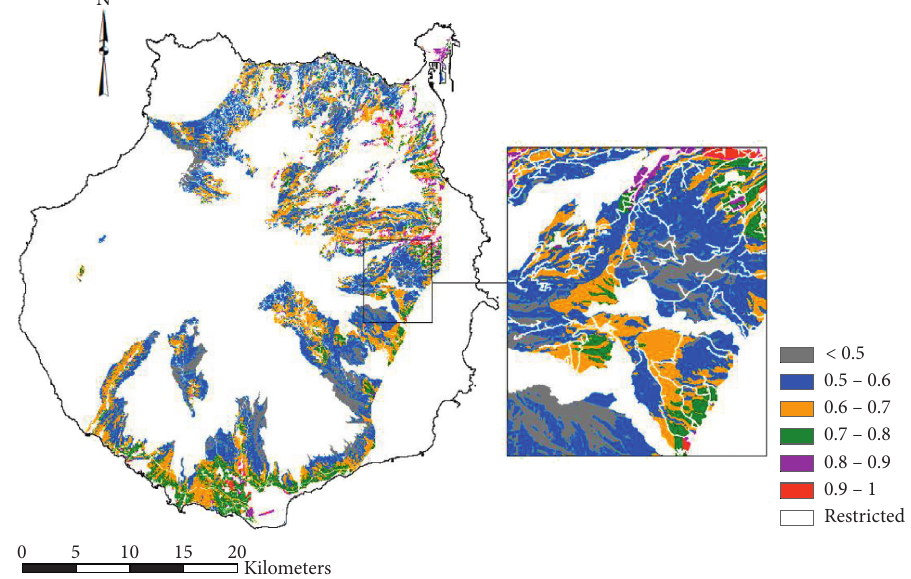
Figure 10: Solar suitability Table 5: Distribution of available priority surface area by municipality.